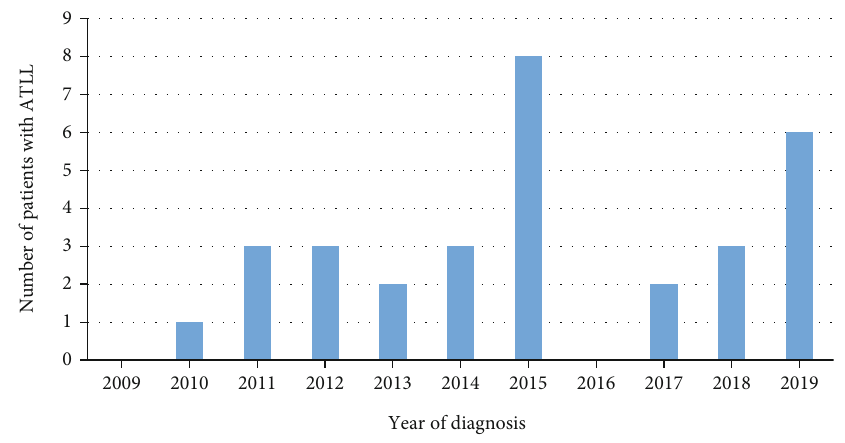
Figure 1: Number of patients diagnosed with adult T-cell leukaemia/lymphoma (ATLL) per year.